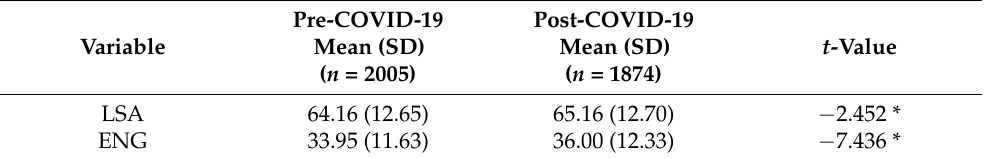
Table 7. Results of independent t -test regarding COVID-19.